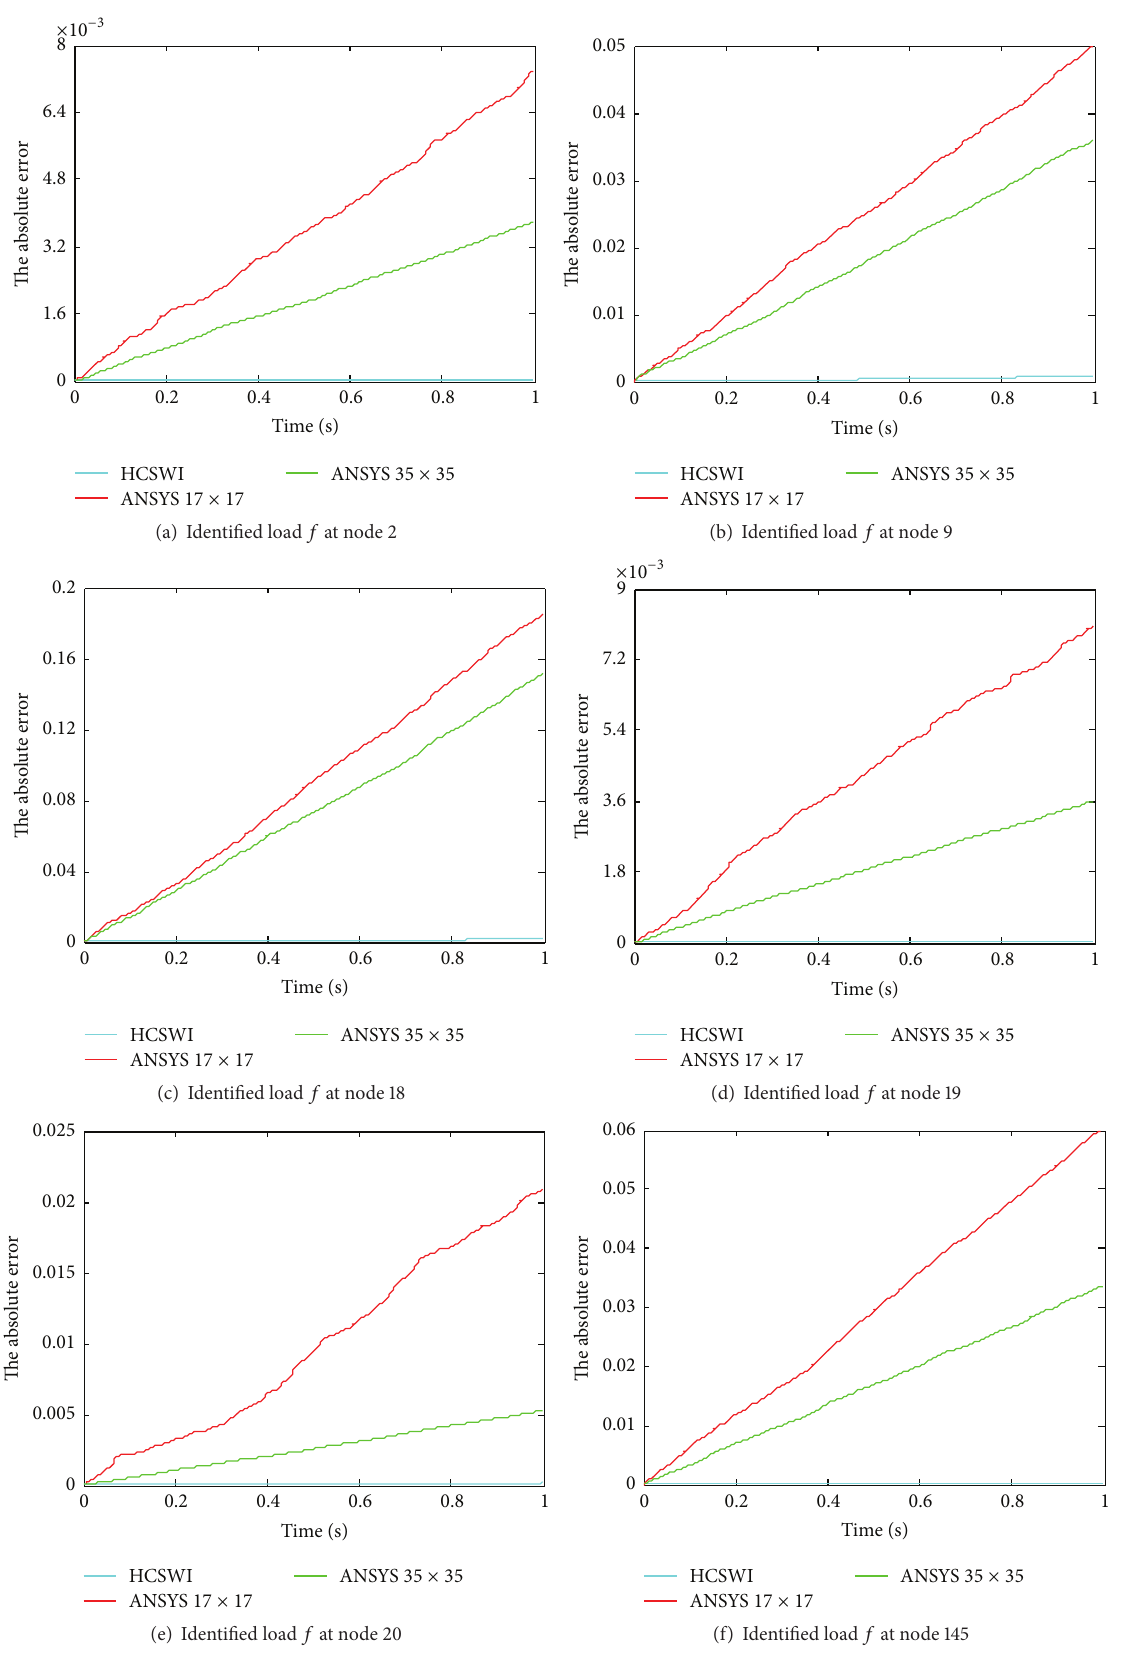
Figure 9: The absolute error with excitation 𝑓 applied at node